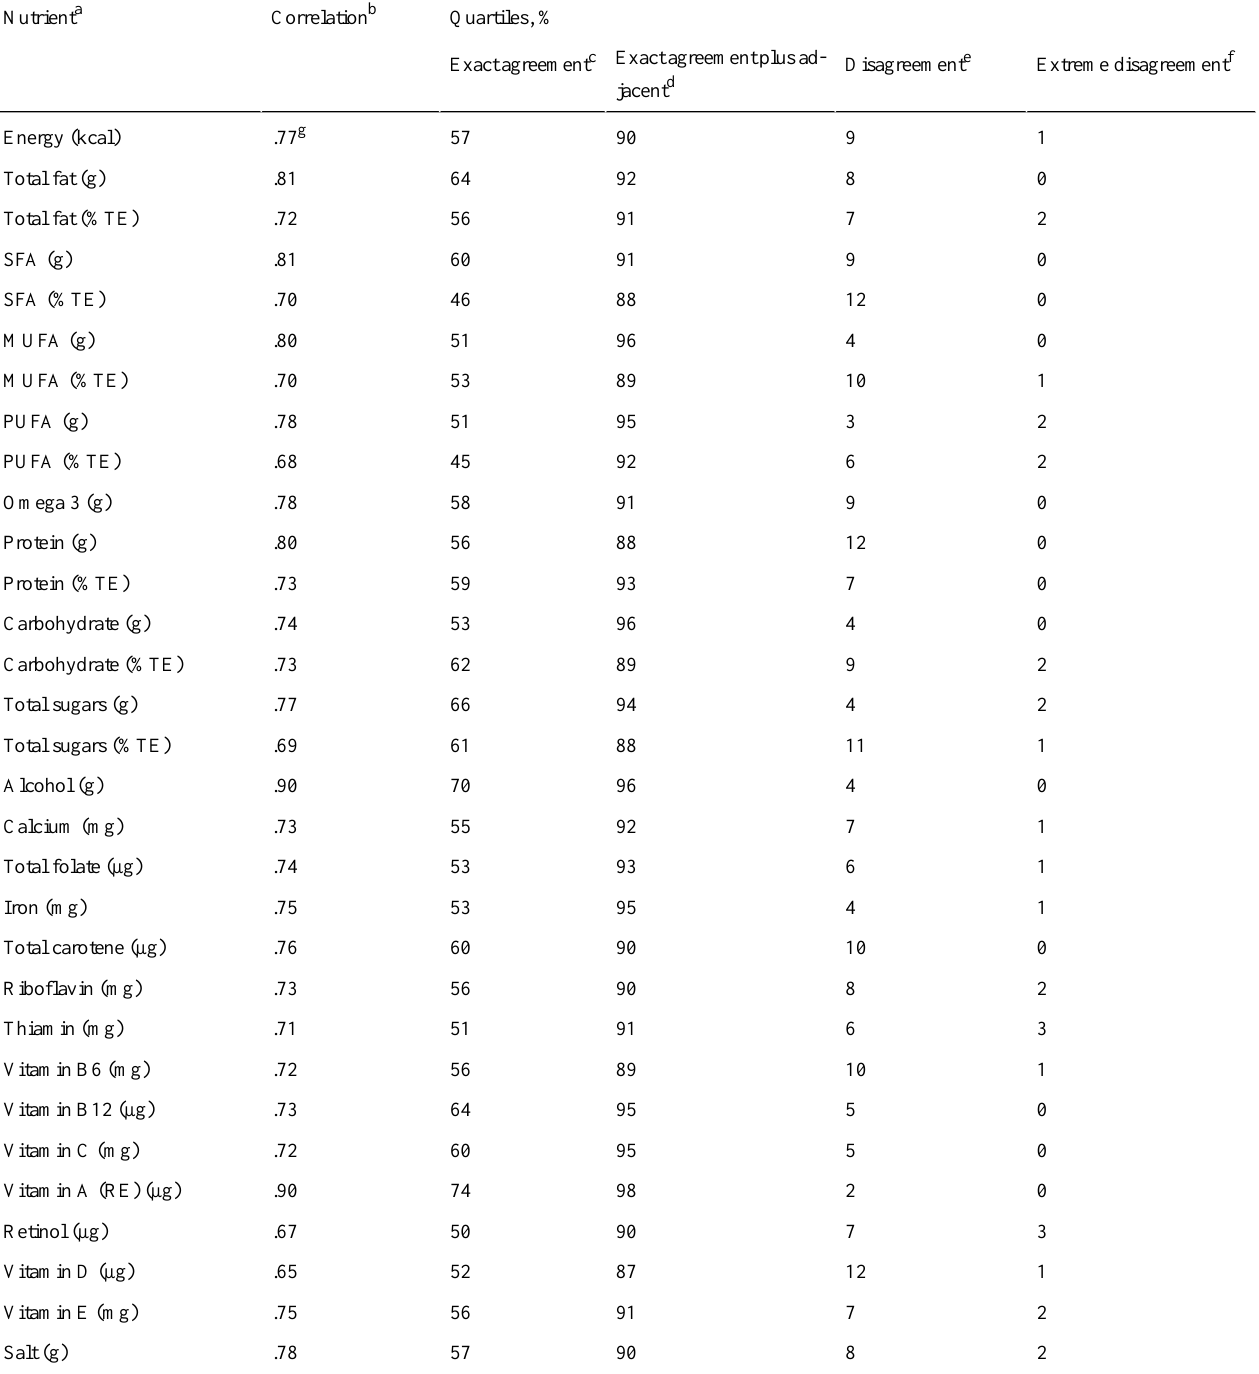
Table 3. Unadjusted correlation coefficients and cross-classification of quartiles of mean energy and nutrient intakes derived from repeat measures of the online Food4Me FFQ